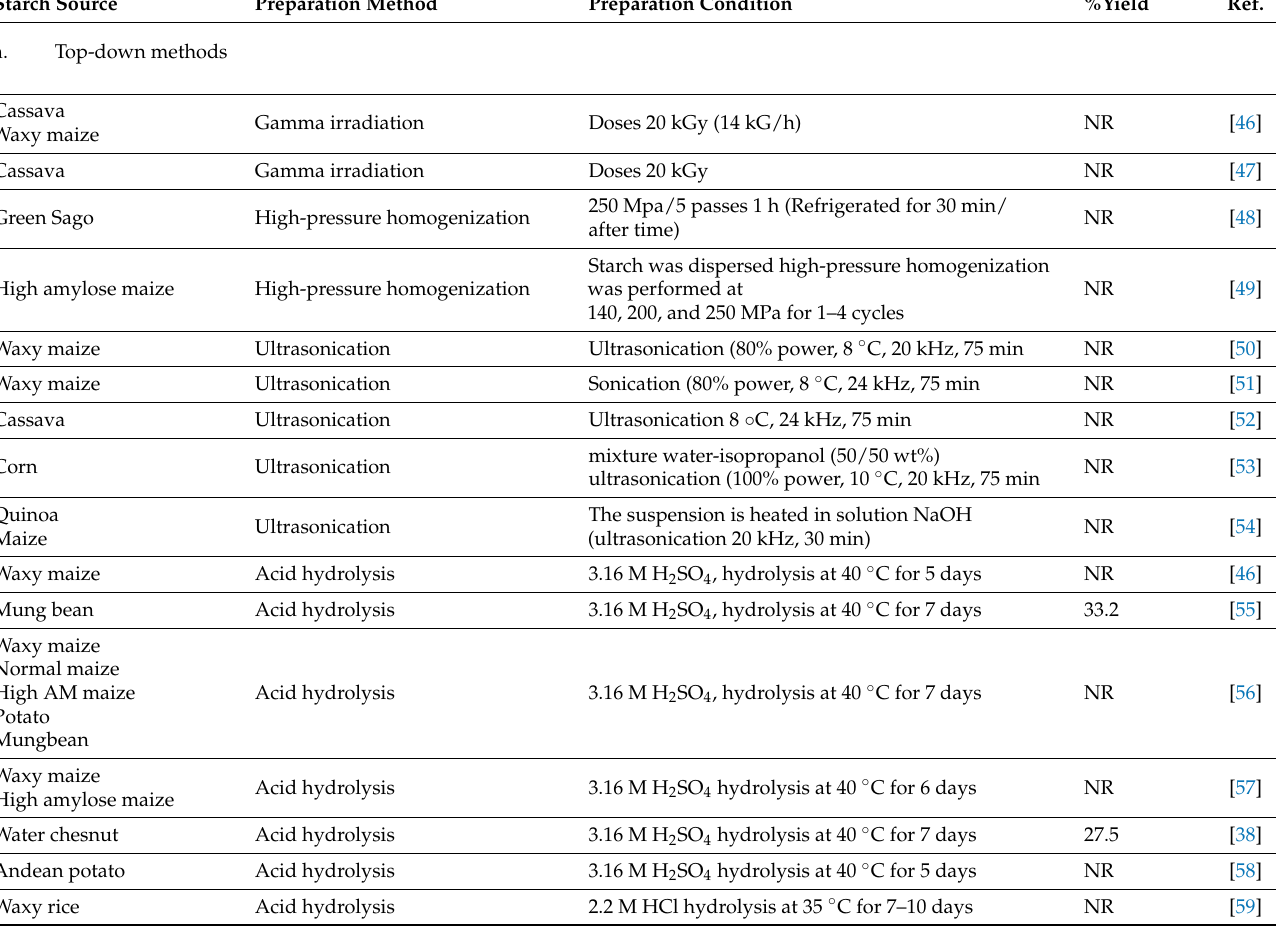
Table 1. Preparation of SNPs by various